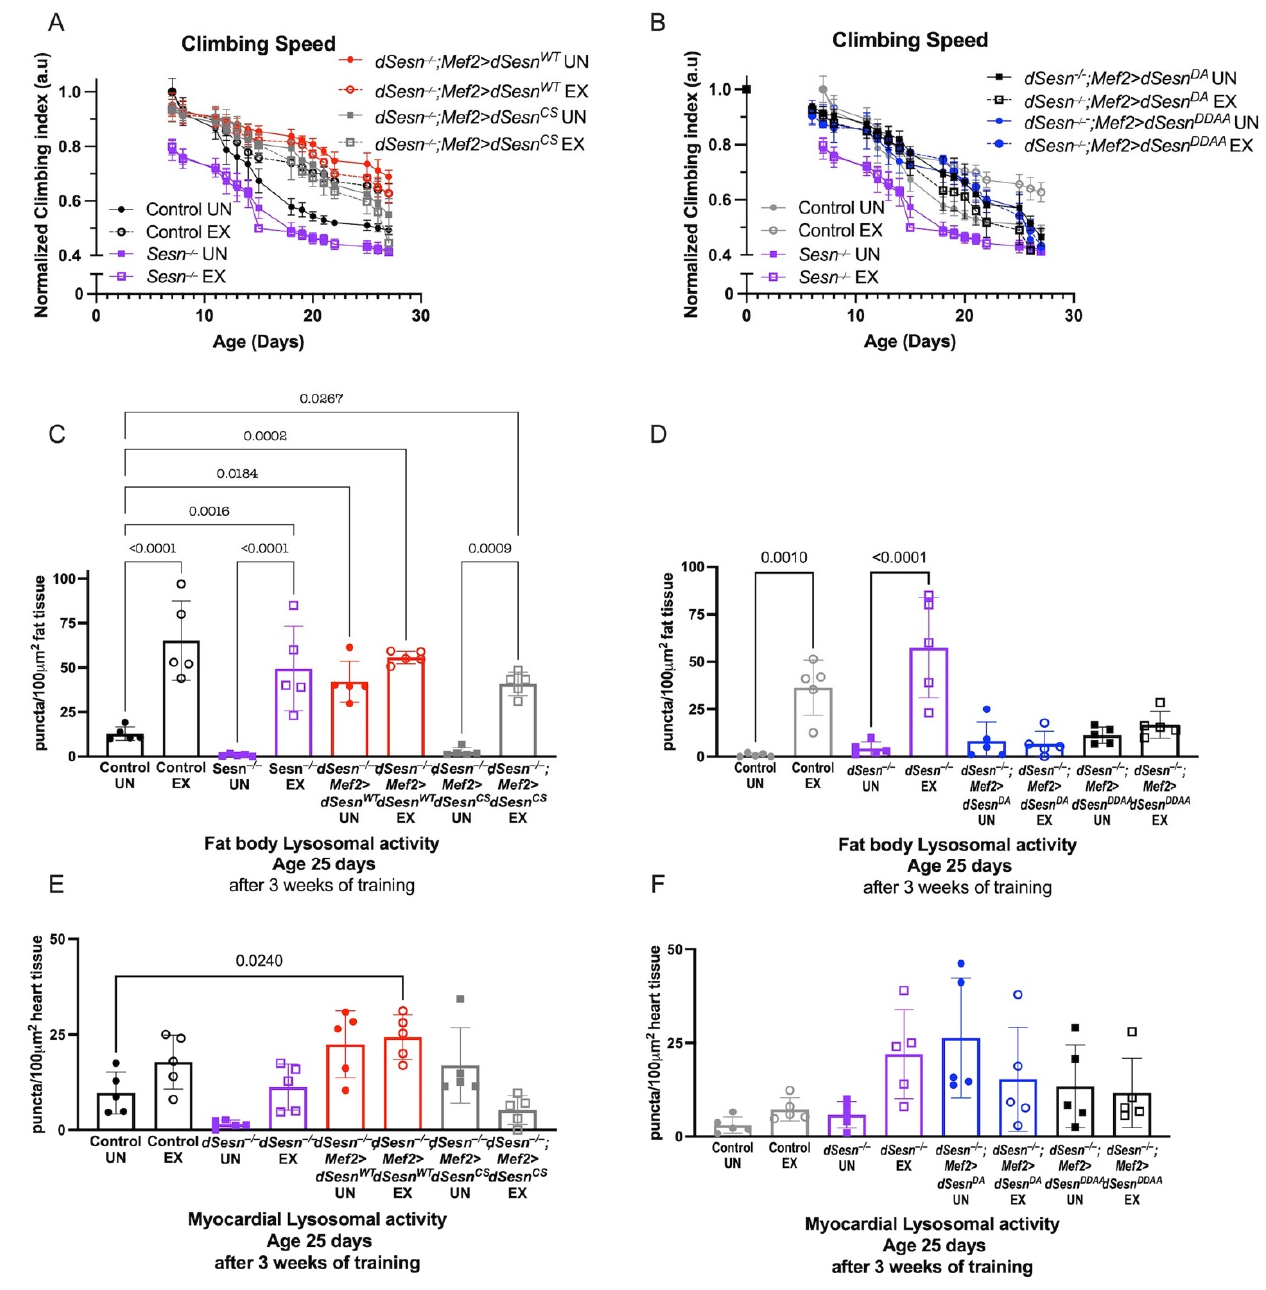
Figure 3. Wild-type dSesn expressed in muscle of dSesn − / − flies improves climbing speed and increases fat body lysosomal activity. Wild-type, C86S, D423A, D423A/D424A dSesn transgenes were expressed in muscle of dSesn − / − flies. ( A , B ) dSesn − / − ;Mef2 > dSesn WT climb faster than dSesn − / − ;Mef2 > dSesn CS (shown in ( A )), dSesn − / − ;Mef2 > dSesn DA and dSesn − / − ;Mef2 > dSesn DDAA flies (shown in ( B )) whether exercised or not (2-way ANOVA, genotype effect, dSesn − / − ;Mef2 > dSesn WT compared to unexercised and exercised Mef2 > dSesn CS , dSesn − / − ;Mef2 > dSesn DA and dSesn − / − ;Mef2>dSesn DDAA f lies: p ≤ 0.0335, d15+).